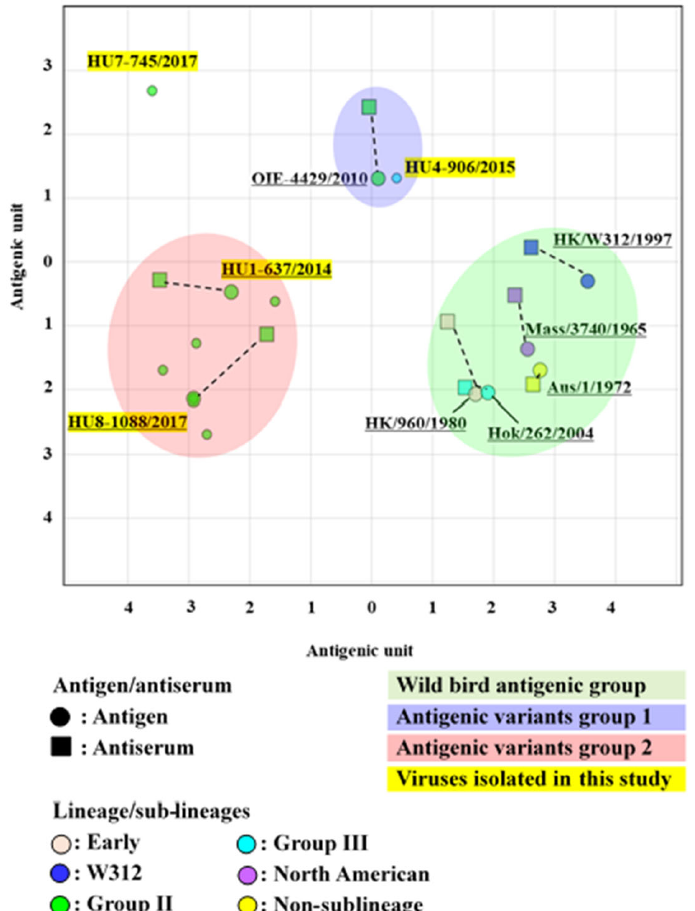
Figure 5. An antigenic map of H6 viruses based on the cross-HI tests on viruses and sera of different lineages. In the antigenic map, both the vertical and horizontal axes represent the antigenic distance. The spacing between the grid lines represents a 1 antigenic-unit distance, corresponding to a 2-fold dilution in the HI assay (2 units correspond to a 4-fold dilution, 3 units correspond to an 8-fold dilution, etc.). Different antigenic groups are indicated by different colors (green, blue, and red). Dotted lines indicate a combination of the homologous viruses and antisera.